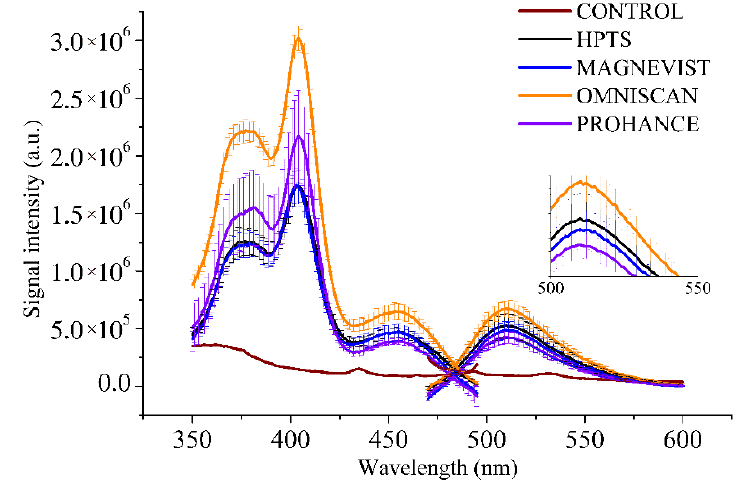
Figure 8 . Excitation and emission spectra acquired before cell lysis . Figure 8. Excitation and emission spectra acquired before cell